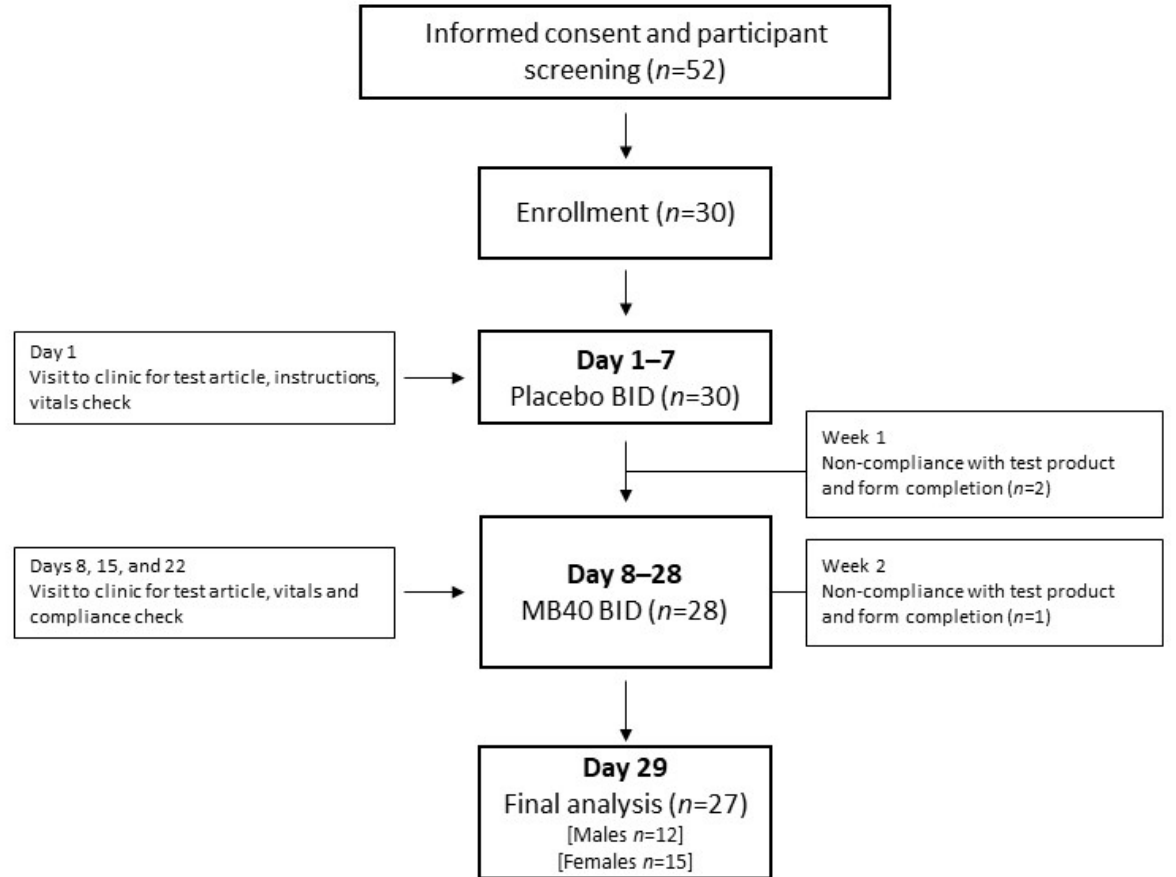
Figure 1. Human Safety and tolerability study design. BID = taken twice daily